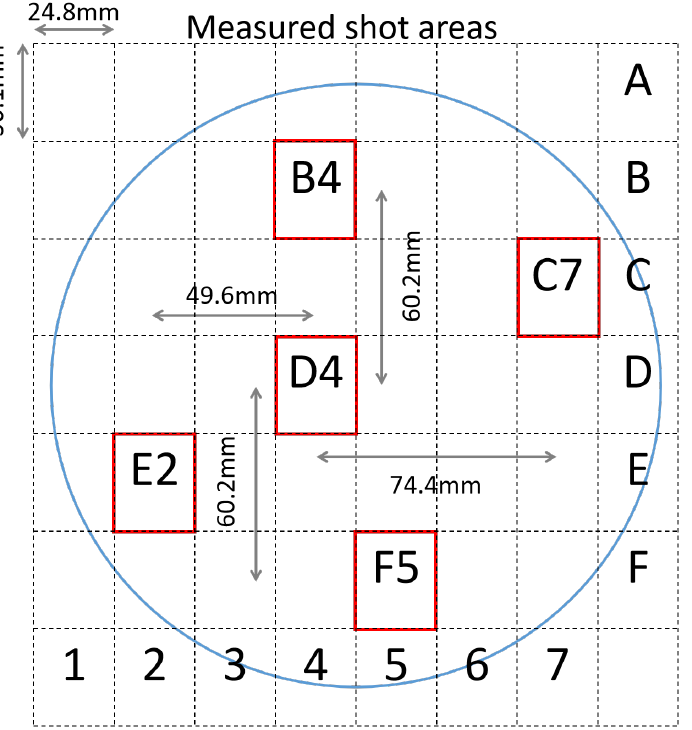
Figure 6. Diagrams of an 8-inch SOI wafer and the locations of five devices under